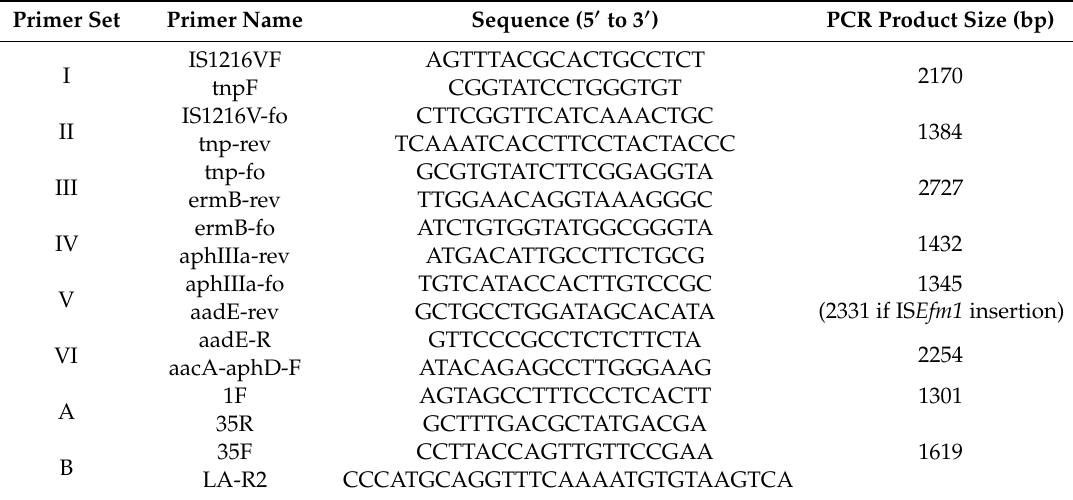
Table 1. Primers used in this